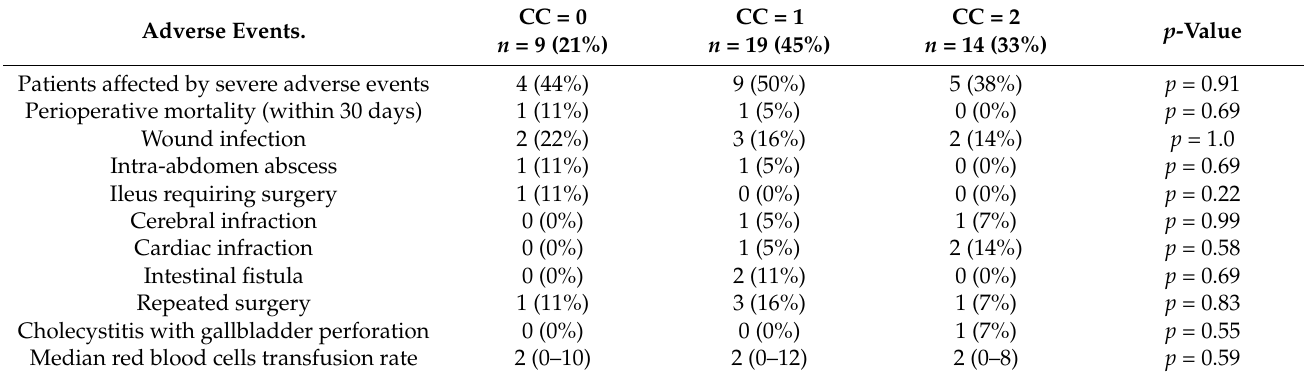
Table 2. The analysis of adverse events and perioperative outcomes among patients treated with total colectomy for ovarian cancer.